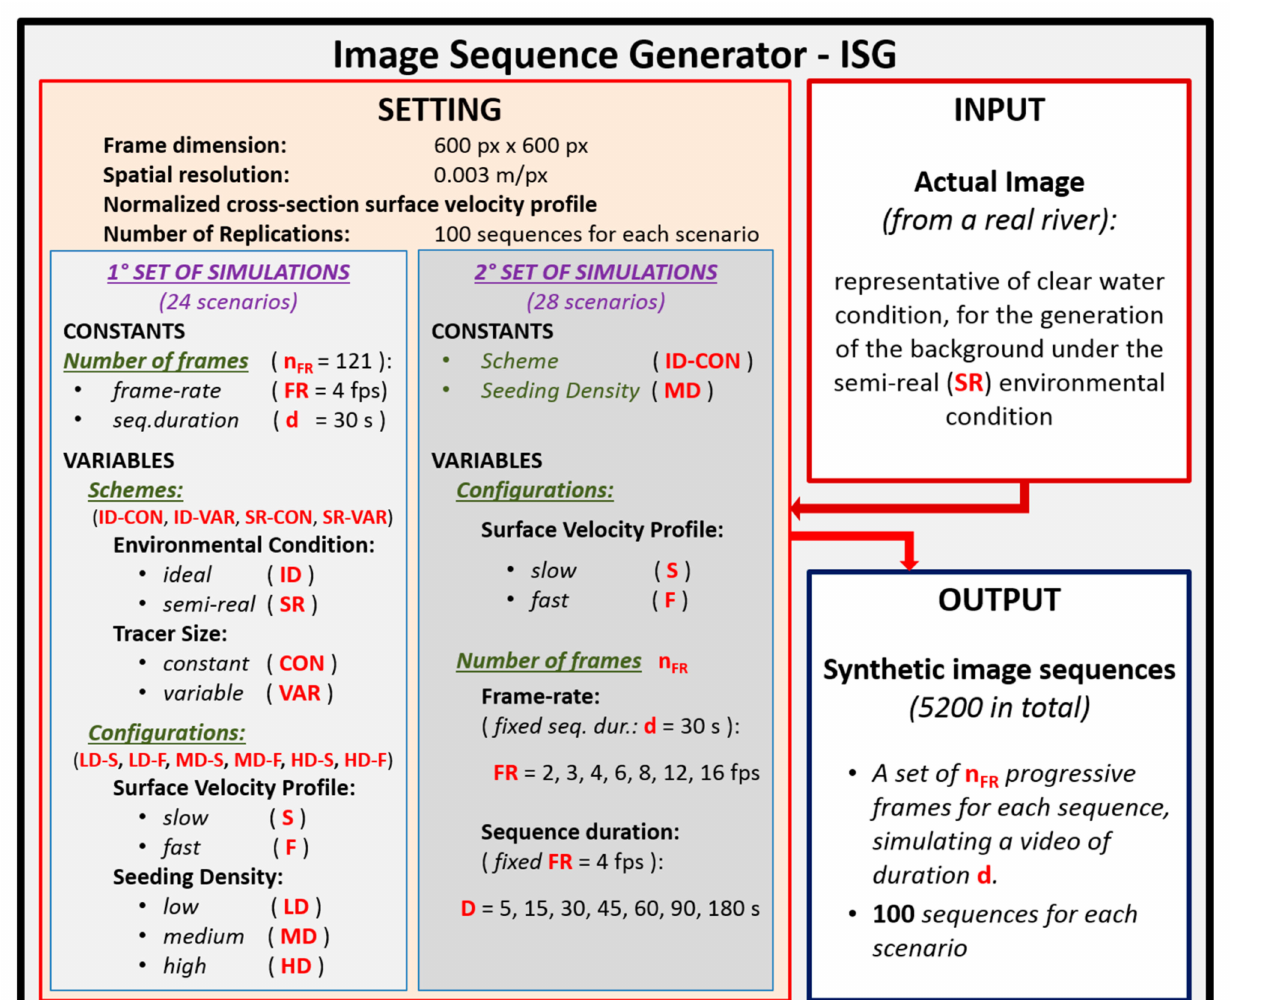
Figure 2. Settings, input and output for the Image Sequence Generator (ISG). Parameters used for the generation of the various scenarios for the first and the second set of simulations are reported in the ISG setting box, distinguishing between constant and variable parameters and highlighting the corresponding symbols in